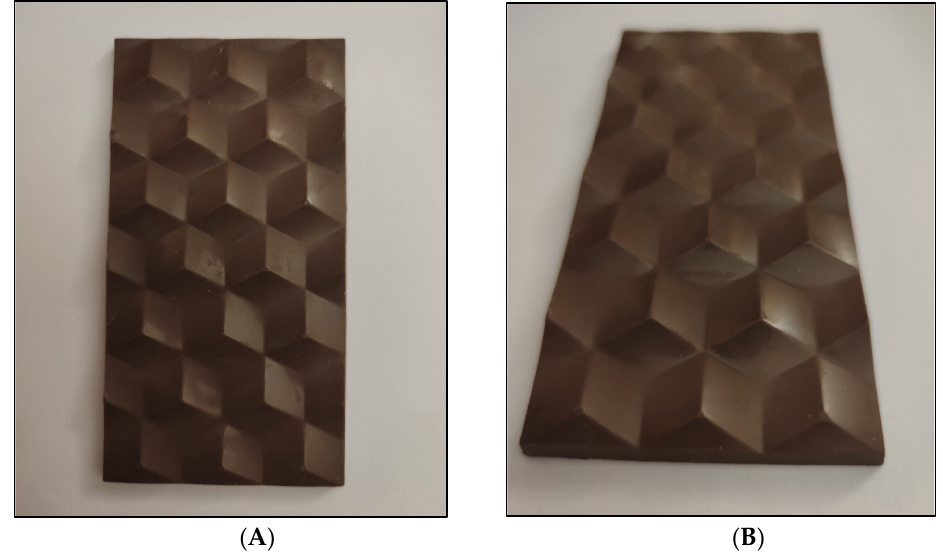
Figure 2. Bar of raw chocolate: ( A )—view from above, ( B )—view from the front. Table 2 presents the nutritional composition of the raw chocolate produced in the experiment (MAN) compared to the composition of the commercial products (COM 50% and COM 64%) and to the composition of the cocoa beans from which the experimental product was derived. Table 2. Nutritional composition of raw chocolate, commercial chocolates and cocoa beans .